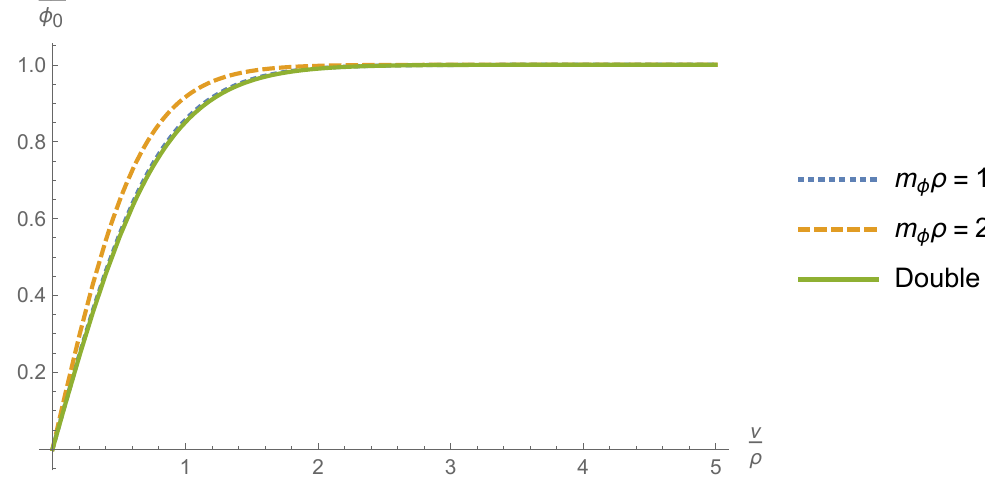
Figure 13 . Numerical solution for the Nielsen-Olesen vortex ( q; l ) = (2 ; 2) in anti de Sitter space in the m A 0 limit with the Higgs (cid:12)eld Compton wavelength 1 =m (cid:30) = 2 (cid:26) , and 1 =m (cid:30) = (cid:26)= 2. The # solutions are compared to the exact double BPS